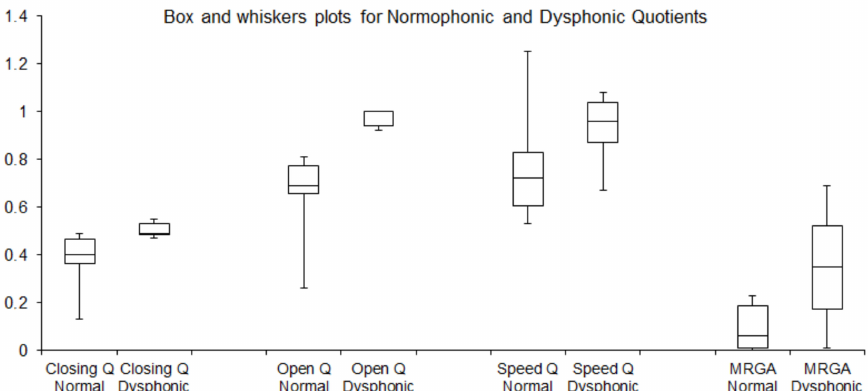
Figure 13. Box-and-whisker plots of calculated quotients for normophonic and dysphonic subjects. The upper and lower boundaries of the boxes indicate first quartile Q1 to third quartile Q3, respec- tively, while the boundary of the lower whisker denotes the minim value in the data set and the upper whisker boundary denotes the maximum value in the data set.